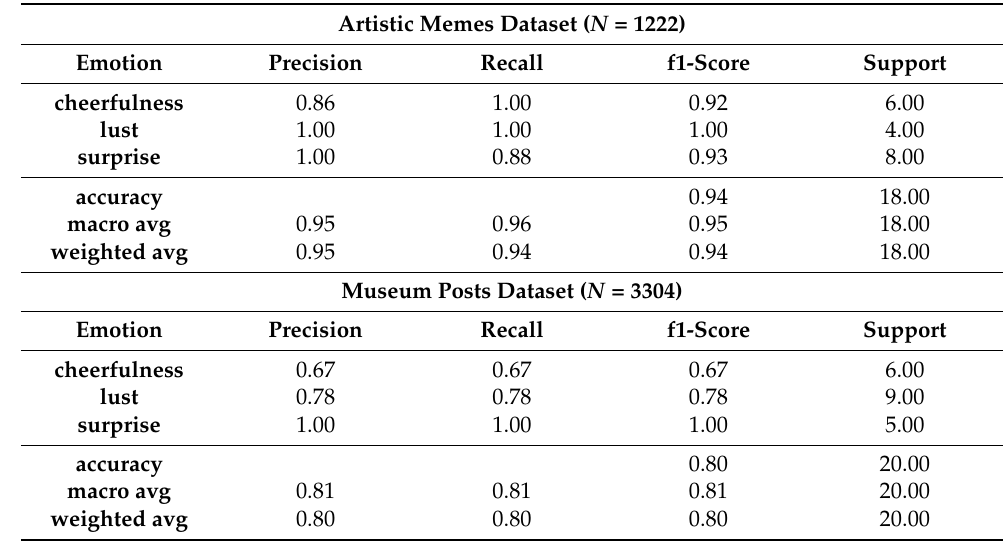
Table 3. Outcomes evaluation by classification report. Correlation between likes, comments, fre- quency, and